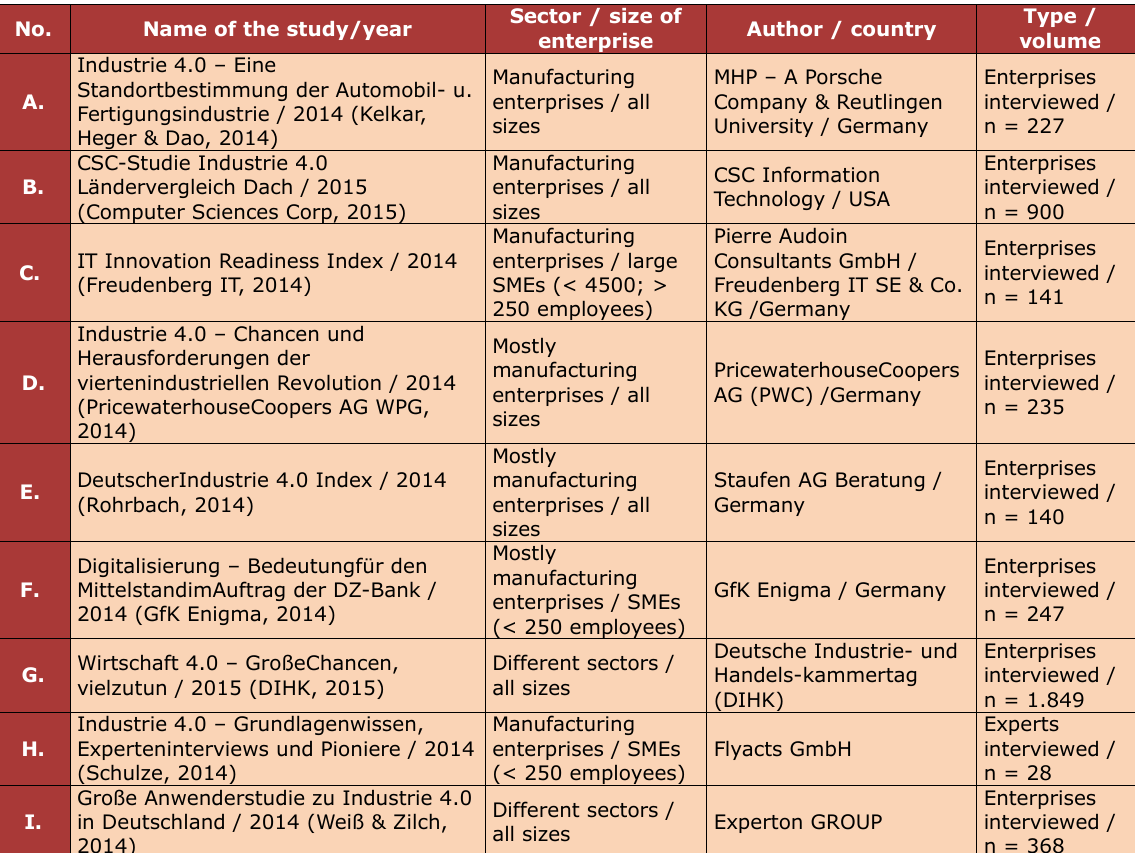
Table 1. List of studies included in the